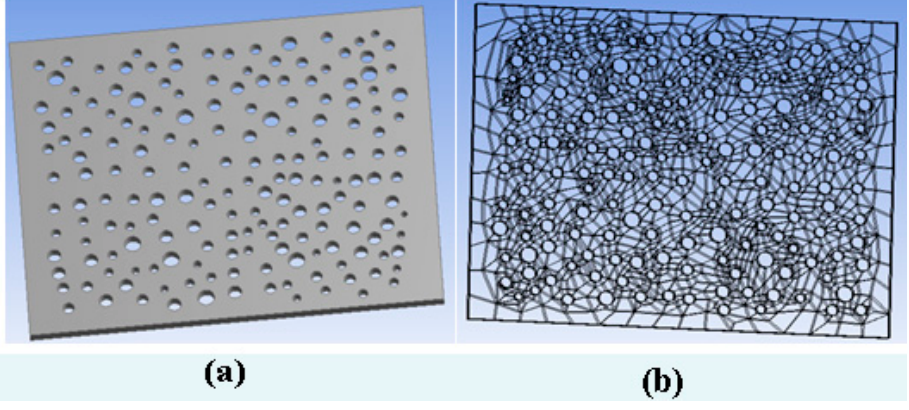
Figure 2. ( a ) Model in the design modeler; ( b ) the meshed model in mesh analysis